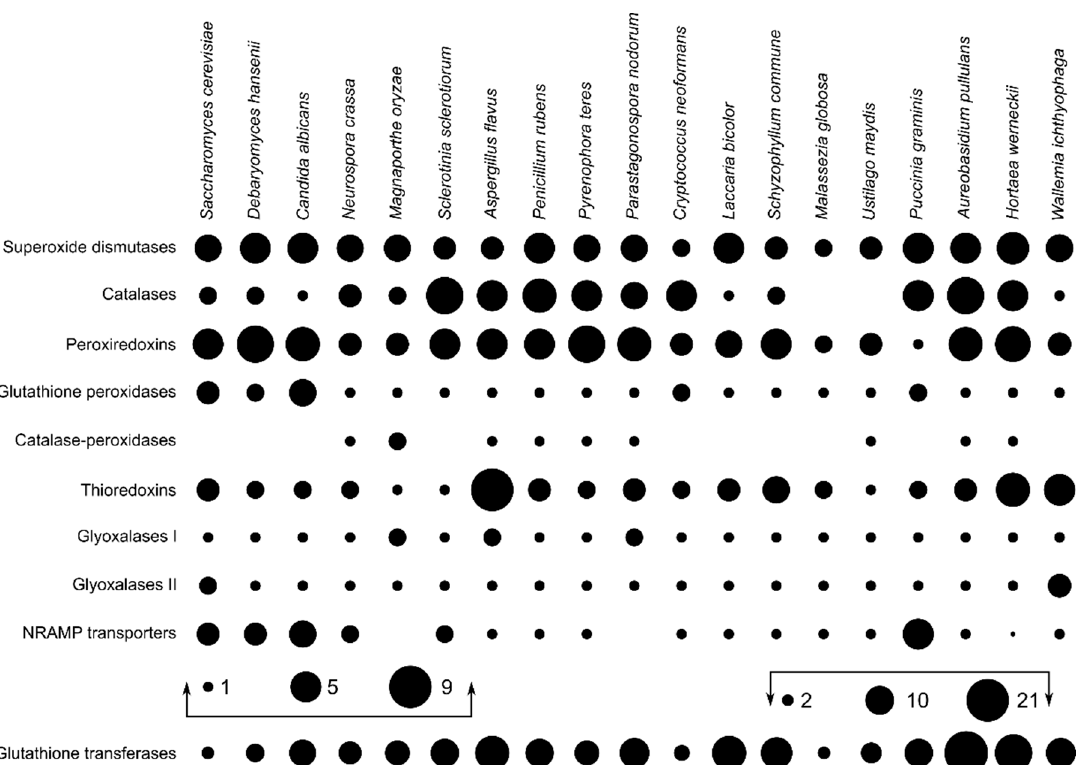
Figure 1. Number of homologues of oxidative stress response genes in selected ascomycetous and basidiomycetous fungi (per haploid genome). The size of dots corresponds to the number of homologues and the absence of a dot marks the absence of a gene in a specific fungus. The numbers of glutathione transferase genes are drawn on a different scale. NRAMP: natural resistance-associated macrophage proteins.